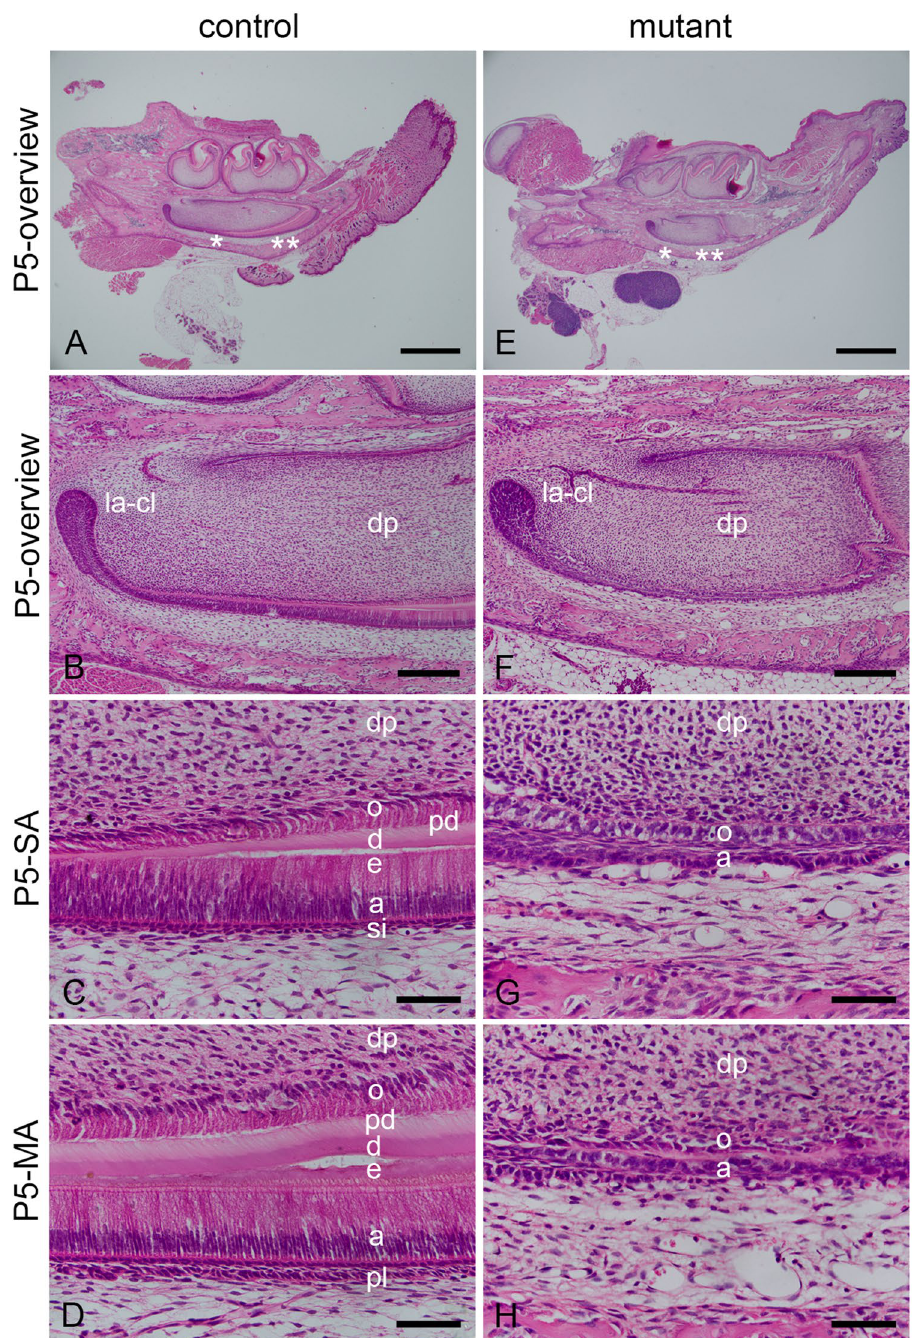
Figure 2. Hematoxylin and Eosin staining in cells of the developing teeth of control and mutant K320E- Twinkle Epi mice at P5. The epithelial cells of the cervical loop ( A ,B), stratum intermedium (si) ( C ; the region is shown in A by one asterisk) and papillary cell layer (pl) ( D ; the region is shown in A by two asterisks) from control mice incisor at P5 are detected in a cellular order with two up to three cuboidal cell layers. In the P5 control, the odontoblasts are well ordered and structured ( C , D ). However, in the mutant mice at P5, the ameloblasts and odontoblasts are severely damaged (E–H). The labial cervical loop epithelium is still intact ( E , F ). In comparison with control mice at P5, the secretory ameloblasts ( G ; the region is shown in E by one asterisk) and mature ameloblasts ( H ; the region is shown in E by two asterisks) of mutant mice are shorter and disorganized. Compared to the control, the stratum intermedium ( G ) and papillary ( H ) layers are not identifiable of the mutant K320E-Twinkle Epi mice at P5. In comparison with strong formation of enamel matrix at secretory ( C ) and especially at mature ( D ) stages in the control incisor, an enamel matrix is not detectable in incisor of the mutant K320E-Twinkle Epi mice at P5 ( G , H ). a, ameloblasts; d, dentin; dp, dental papilla; e, enamel matrix; la-cl labial cervical loop; o, odontoblasts; pl, papillary layer; si, stratum intermedium; sr, stellate reticulum; Scale bars: A , E = 1 mm, B , F = 200 µm, C , D , G , H = 50